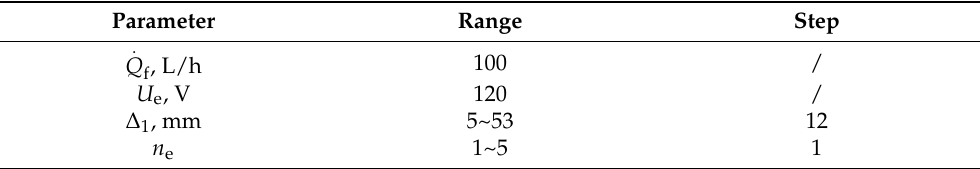
Table 4. Experimental conditions for Factor 2.